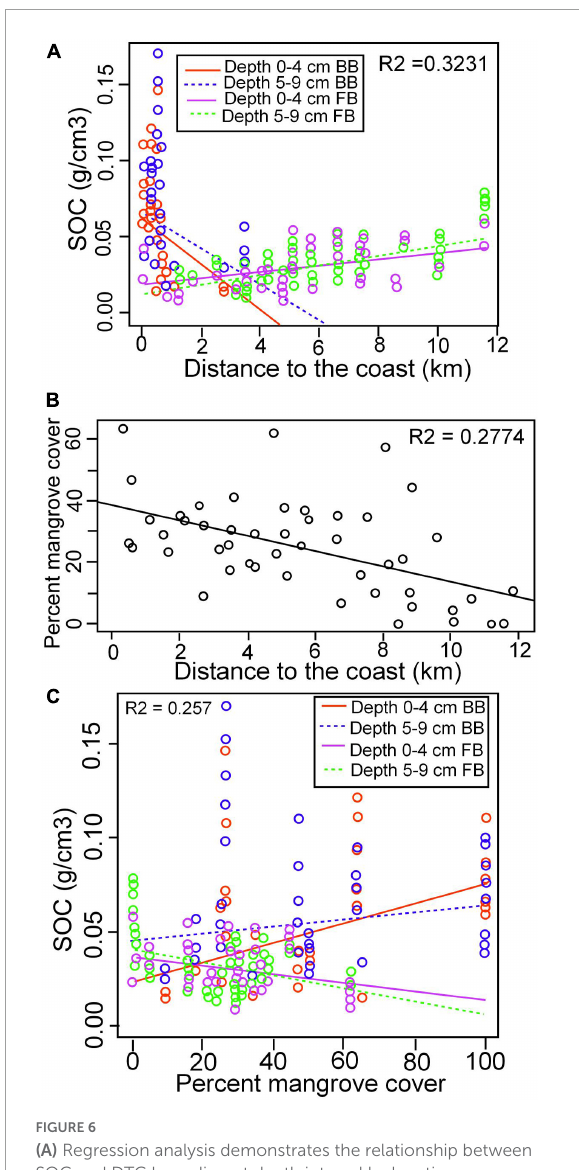
FIGURE6 (A) Regression analysis demonstrates the relationship between SOC and DTC by sediment depth interval by location ( Supplementary Table 1 ). (B) Percent mangrove cover as a function of distance to the coast (data from all 50 vegetation sites including the 22 sediment core sites) and (C) Regression analysis demonstrates the relationship between SOC density and percent mangrove cover by location and sediment depth interval ( Supplementary Table 1